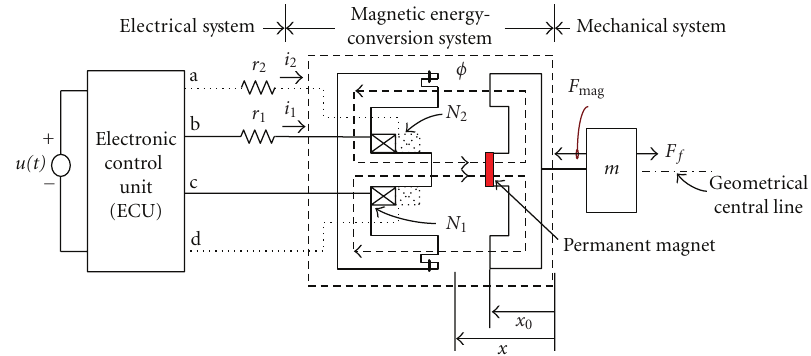
Pe r manent ma g